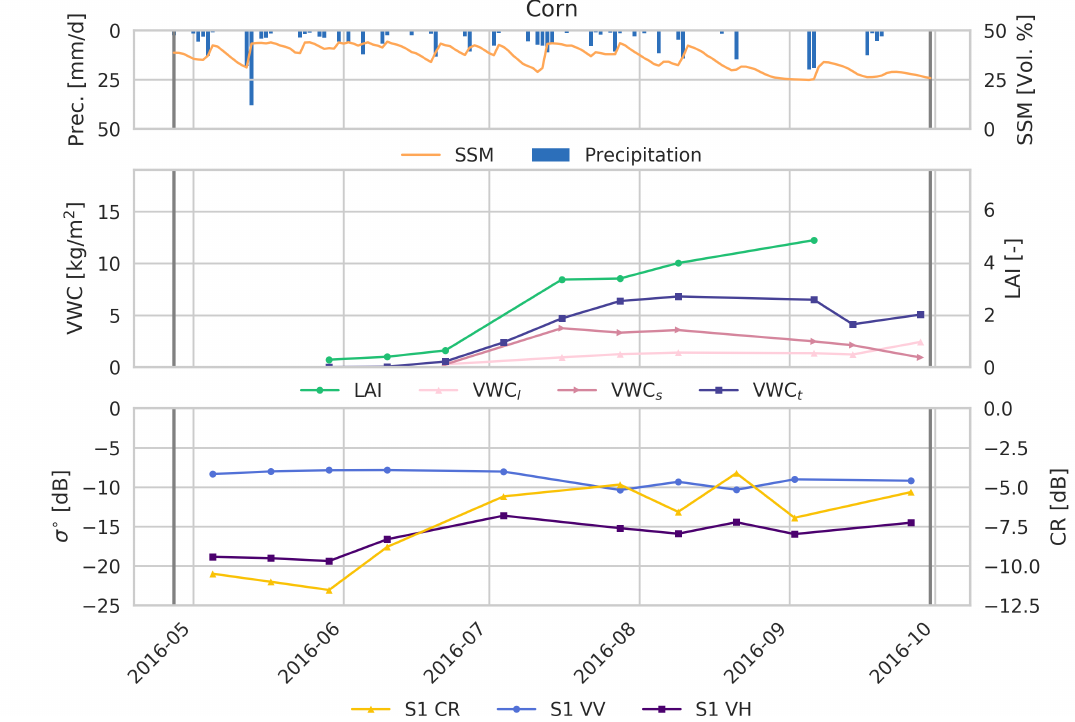
Figure 4. Time series of Sentinel-1 and in situ variables as in Figure 2 for corn